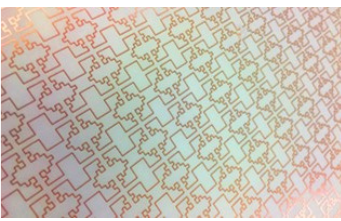
Figure 25. The first manufactured fractal metamaterial. (Image source: https://www.fractenna.com/, accessed on 22 June 2022).